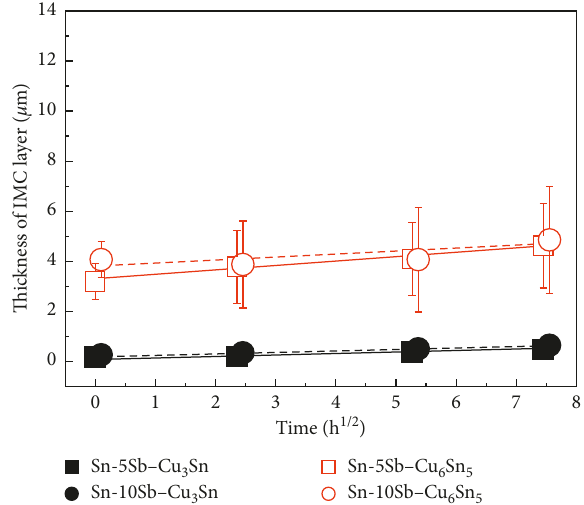
Figure 12: Thickness of IMC layers versus square root of heat aging time at 100 °